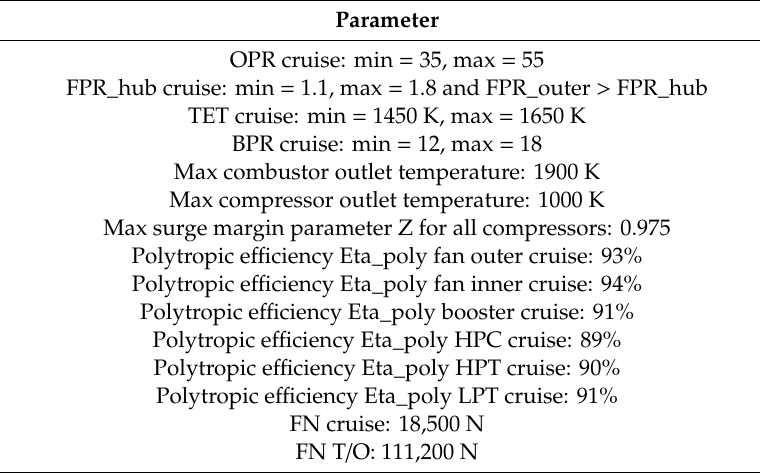
Table 1. Engine performance optimization